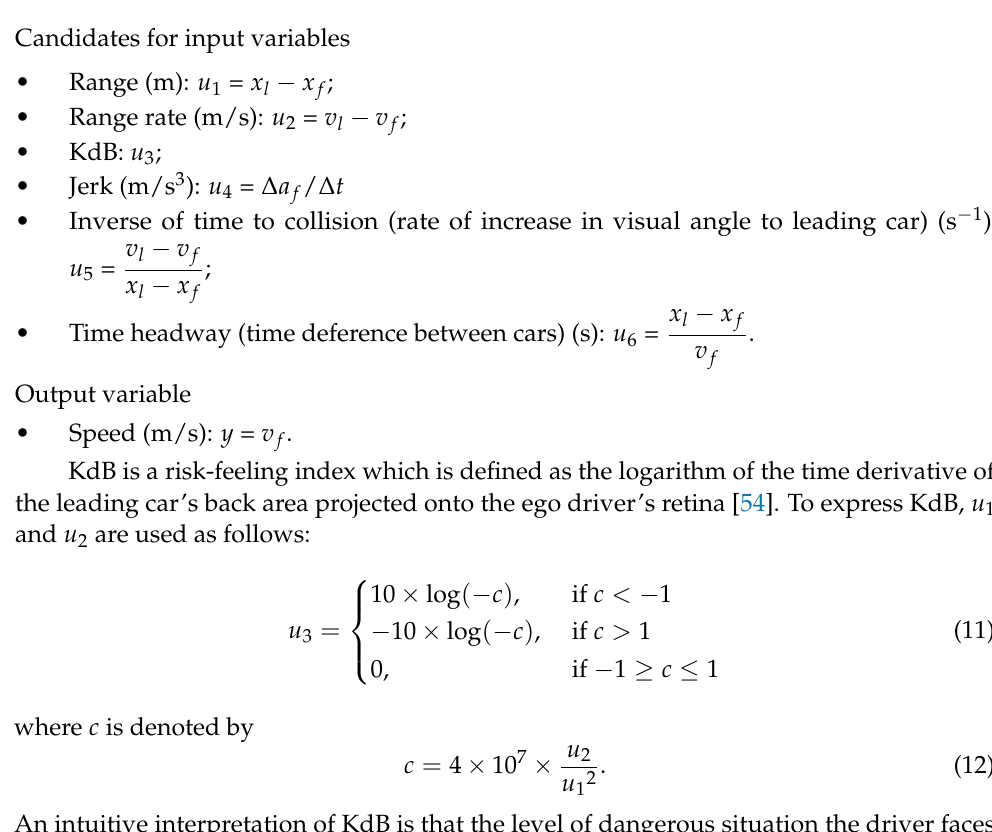
Figure 5. Definition of variables between ego car and leading